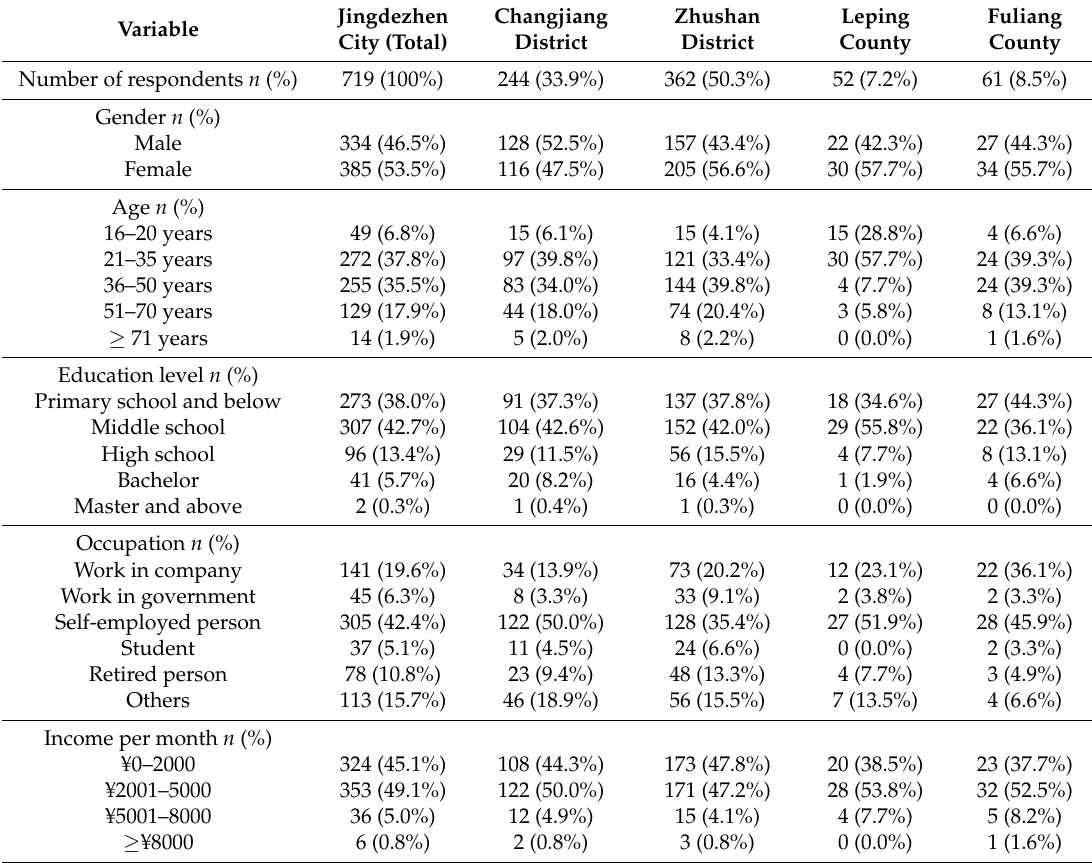
Table 2. The Socio-Demographic variables of the respondents (N =